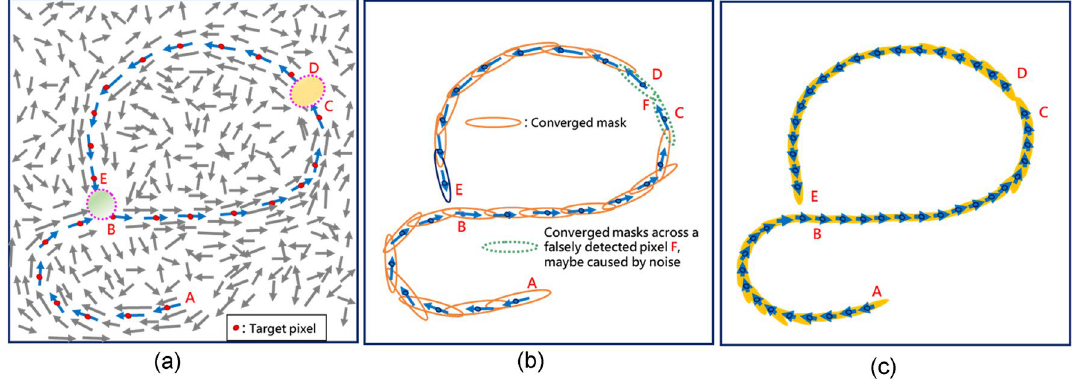
Figure 2. ( a ) Principal directions for a set of edges probed by the proposed deformable mask. ( b ) a set of converged masks ( c ) the corresponding contiguous contour from edge point A to edge point